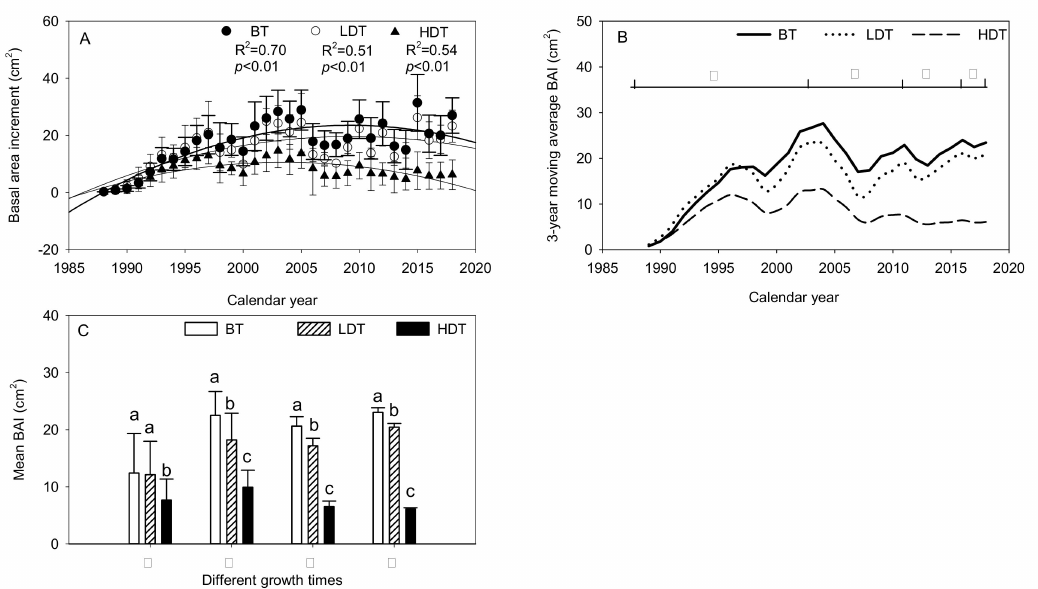
Figure 4. Di ff erences in basal area increment (BAI) ( A ) and 3-year moving average BAI ( B ) between Mongolian pine trees of the three density groups. Di ff erence in mean BAI ( C ) among the three densities in di ff erent growth periods. Lower-case letters indicate significant di ff erences at p < 0.05.